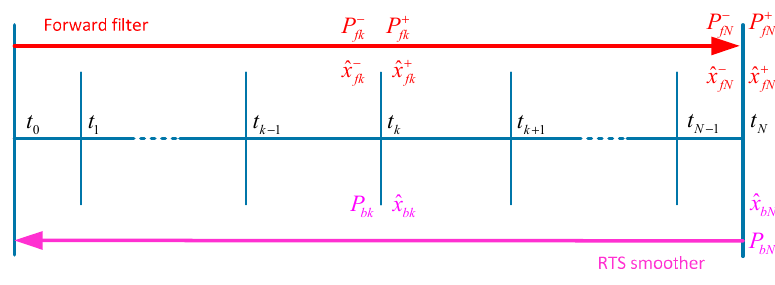
Figure 5. The RTS smoothing algorithm computational process.